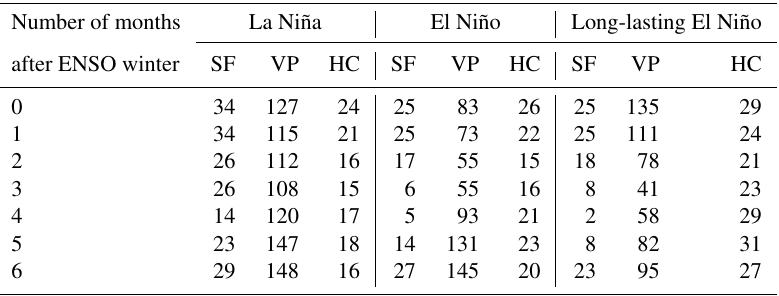
Table 2. List of the maximum strength of the NH anticyclone (SF in 10 6 m 2 s − 1 ), Walker circulation (VP in 10 5 m 2 s − 1 ) and Hadley circulation (HC in 10 5 m 2 s − 1 ) after La Niña, El Niño and long-lasting El Niño found inside the blue domains in Figs. 2, 5 and